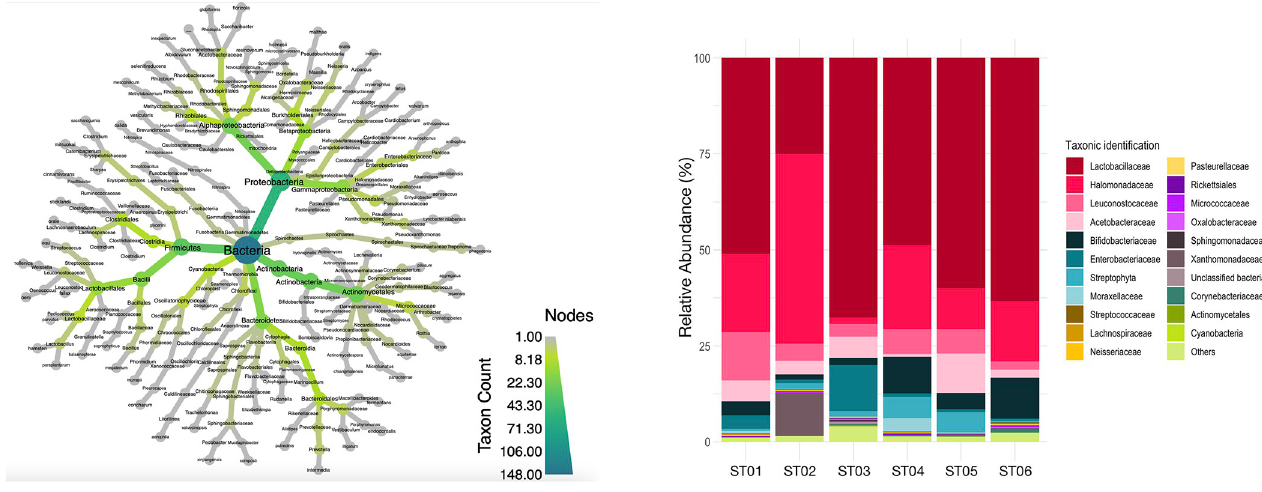
Fig 2. The taxonomic composition at phylum and genus levels. (a) Heat tree of the abundance of bacterial taxa at different ranks present in the T . pagdeni stingless bees that were determined using culture-independent approach. The size and color of the nodes and edges are correlated with the abundance of taxa. The central nodes are the total of all the other nodes in the tree for each phylum [42]. (b) The gut bacterial composition of T . pagdeni stingless bees from each colony. The columns represent a sample, the colors show different families, and the length of the column represents the relative